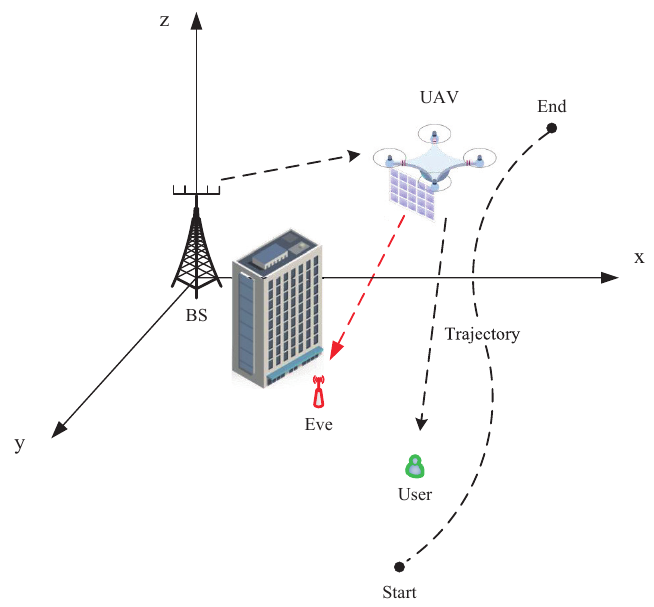
Figure 1. The RIS-aided UAV secure transmission